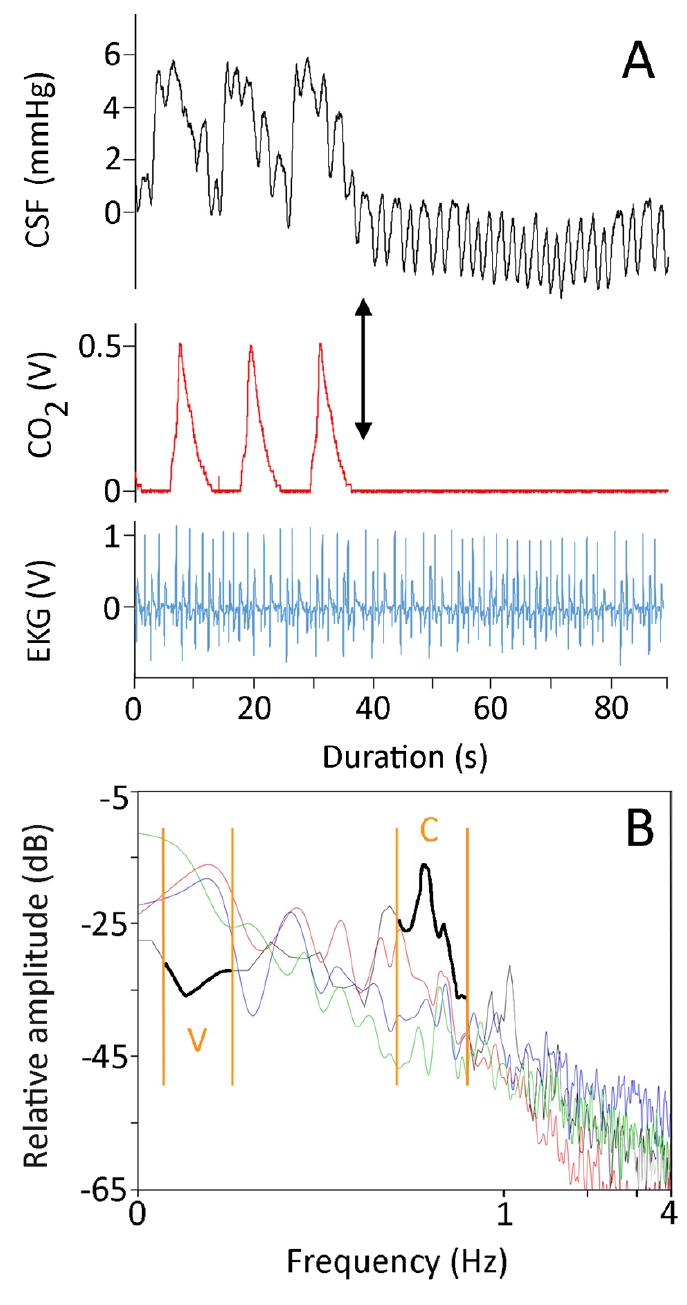
Figure 1. ( A ) For 90 s, simultaneously recorded CSF pressure (black, upper trace), exhalatory CO 2 (red, middle trace), and EKG (blue, lower trace) from Candoia aspera . The left portion of the CSF trace exhibits low-frequency pulses which correspond to the ventilator cycle, and high-frequency pulses which correspond to the cardiac cycle. After three ventilator cycles, the ventilator was stopped (black arrow), forcing the snake into apnea and eliminating the low-frequency pulses from the CSF trace. ( B ) Power spectral analysis of four 90 s traces recorded from four different specimens of Candoia aspera . Three of the specimens (red, green, and blue traces) were ventilating at approximately the same rate and had similar heart rates. The data from the fourth specimen (black trace, highlighted for emphasis) were recorded while the specimen was in apnea; note that under apnea the power of the ventilatory component was lower while that of the cardiac component was higher. The cardiac (C) and ventilatory (V) ranges are denoted by the orange vertical lines. The lower-frequency pressure pulsations were temporally correlated to the ventilator cycle, and disappeared during periods of induced apnea (Figure 1A). Pooling five of these